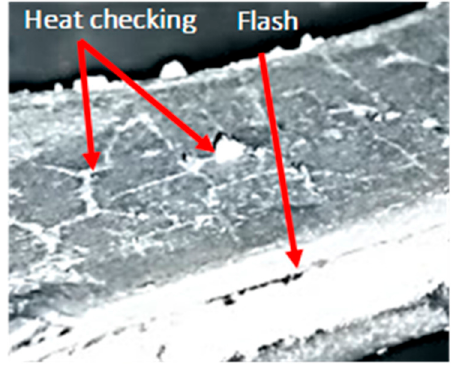
Figure 7. Flash and heat checking (thermal fatigue) marks are typically found on the die’s surface. Such defects can affect the measurements.